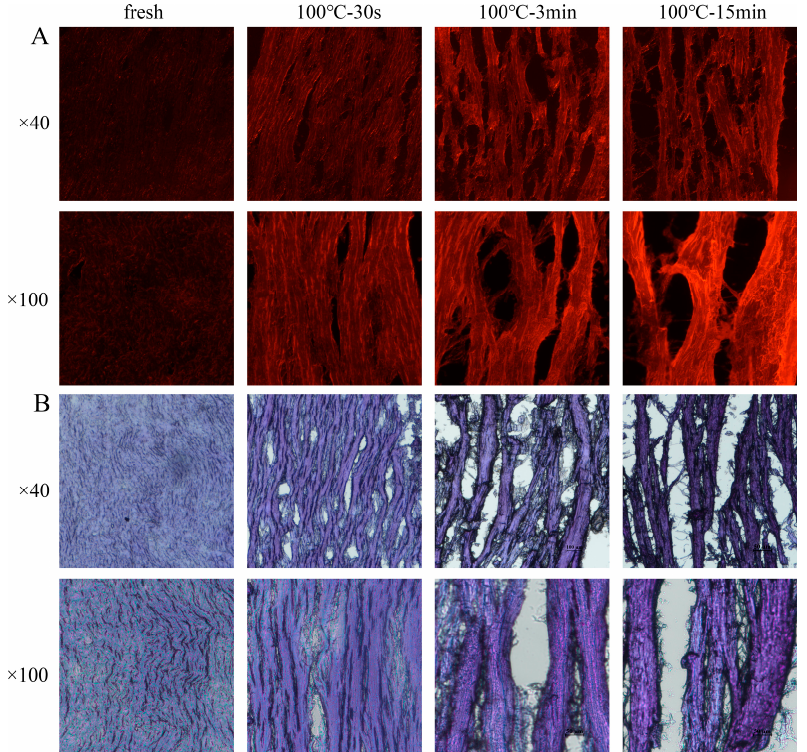
Figure 2. Fluorescence micrographs of longitudinal sections of SAMs after boiling stained by Nile red ( A ) and light micrographs of longitudinal sections of SAMs after boiling stained by bromophenol blue ( B ) at 40× and 100× field of view. 100 °C–30 s, 30-s-boiled sample; 100 °C–3 min, 3-min-boiled sample; 100 °C–15 min, 15-min-boiled sample.